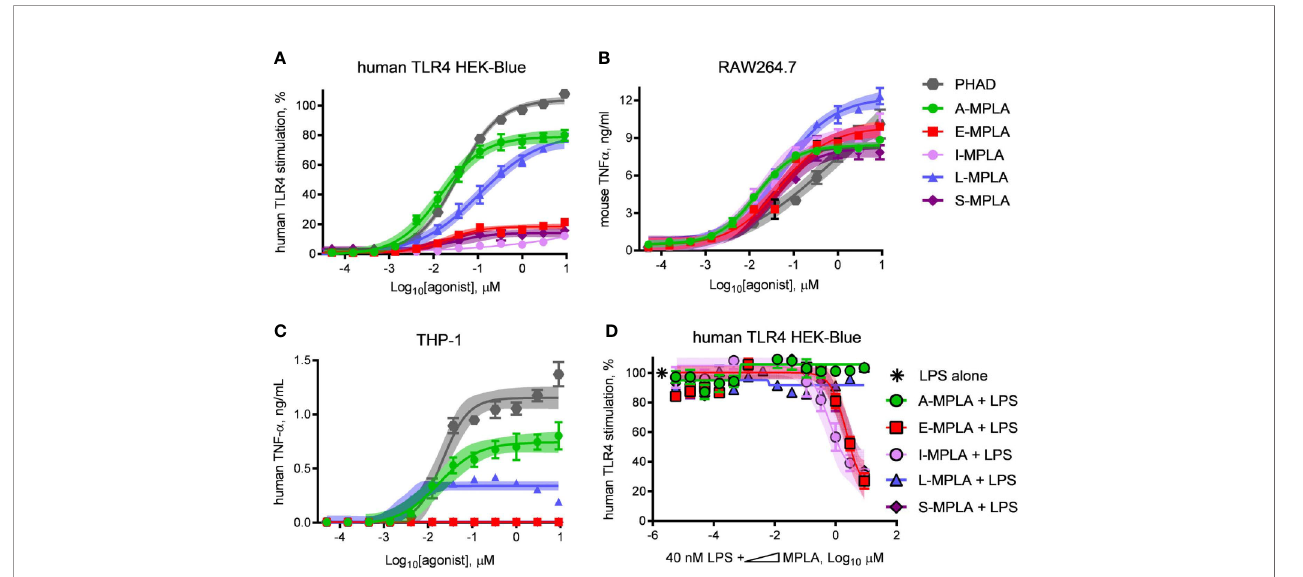
FIGURE 2 | Partial agonist activity of MPLA preparations correlates with presence of TLR4 inhibitors. Research-grade MPLA preparations from fi ve commercial sources were tested for mouse vs human TLR4 stimulatory activity. Secretion of alkaline phosphatase by (A) human TLR4 HEK-Blue reporter cells was used as a marker of receptor stimulation after exposure to increasing doses of MPLA. TNF a production was used as a marker of TLR4 stimulation by (B) RAW264.7 mouse monocytic cells and (C) THP-1 human monocytic cells. Inhibition curves were performed with (D) human TLR4 HEK-Blue cells exposed to a fi xed concentration of LPS alone or in combination with increasing amounts of each MPLA. Symbols and error bars show the average ± SD of (A, B) normalized values (100% = top dose plateau of Lipid A from three independent experiments or of (C, D) cytokine abundance measured in two independent experiment each performed in triplicate. Shaded regions indicate 99% con fi dence intervals within which the true population means should occur 99% of the time. MPLA preparations with the lowest dose plateaus for stimulation of human TLR4 [E-, I-, and S-MPLA in (A) ] were the same as those that inhibited TLR4 stimulation when combined with LPS in (B)